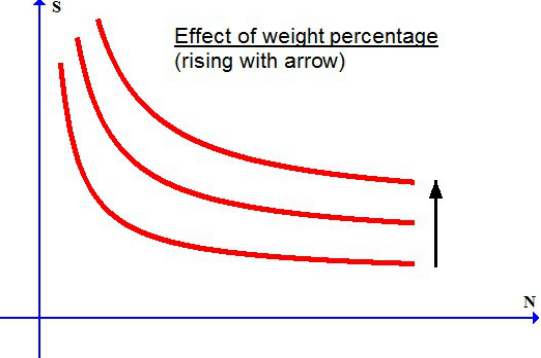
Figure 1. S - N curves for MMCs (metal matrix composites) with different weight percentages of reinforcing particles (S: stress amplitude; N: number to